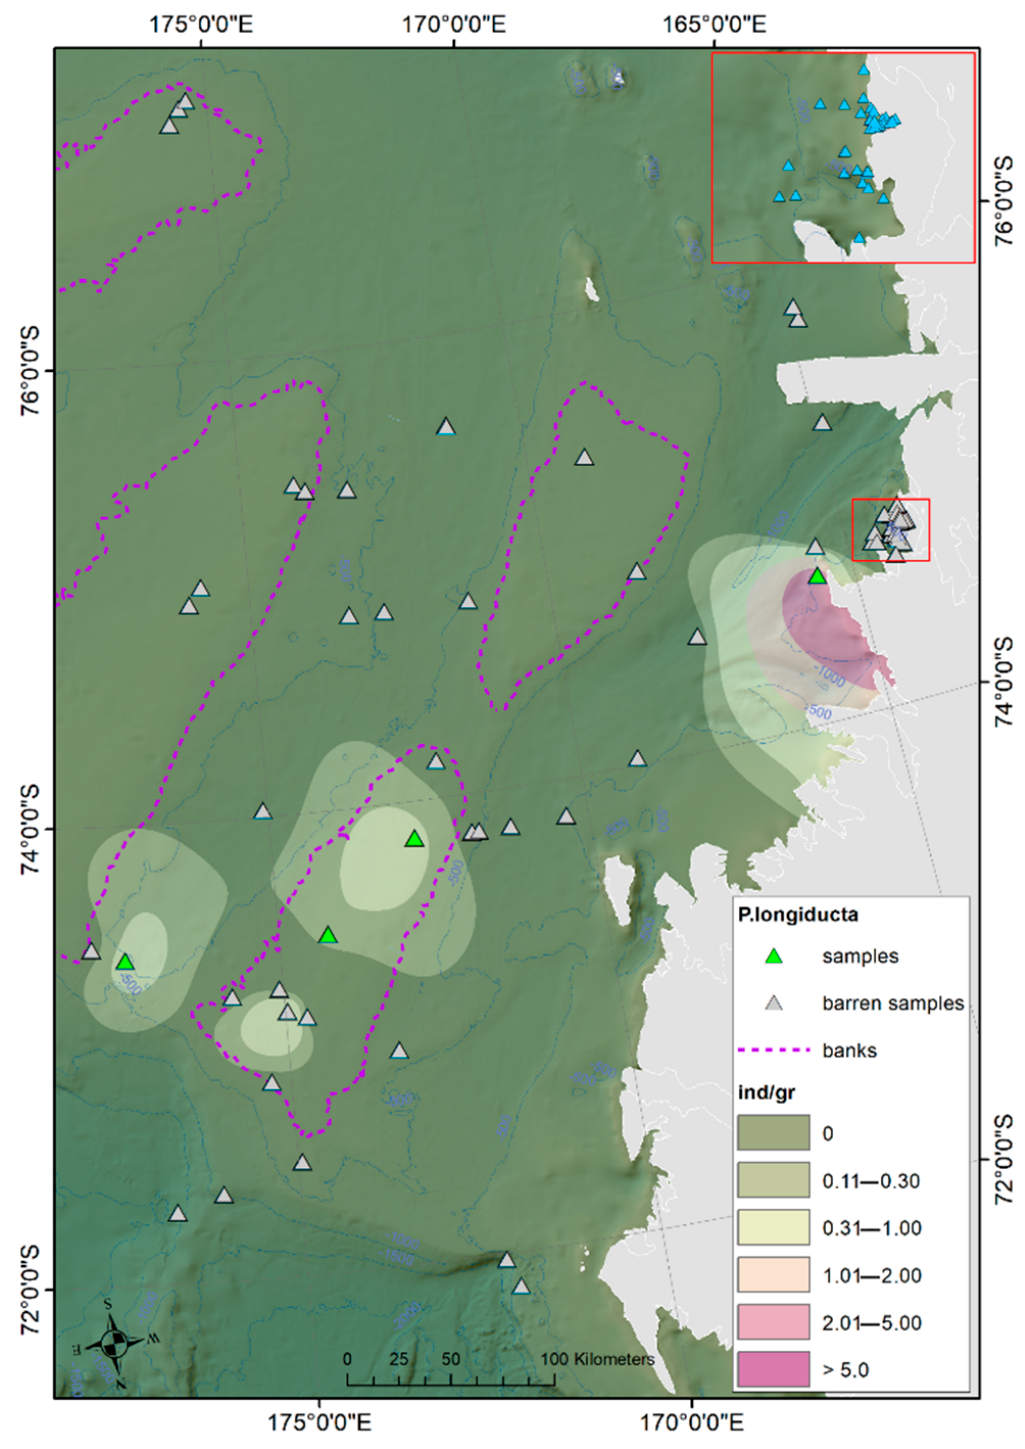
Figure 12. GIS predictive P. longiducta distribution map interpolated in GIS, applying the spline method using barriers. Isobaths every 500 m.